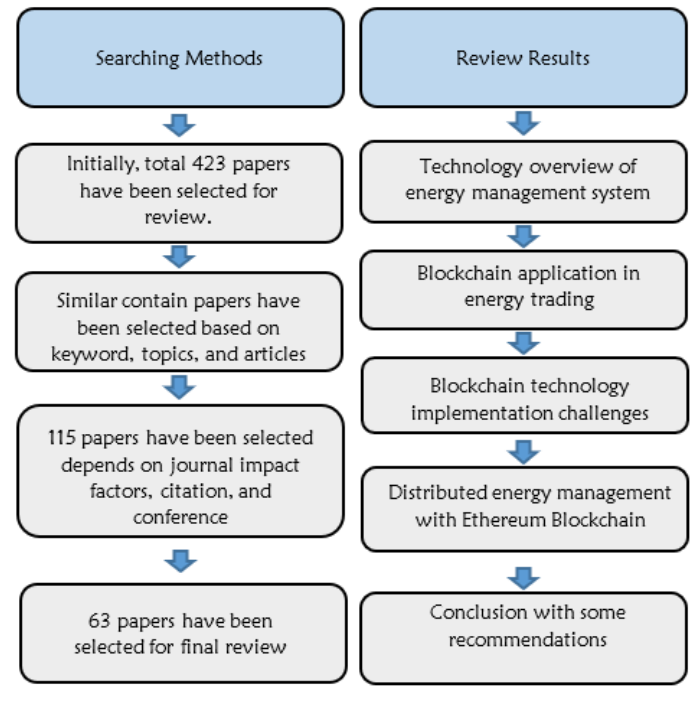
Figure 1: Research Methodology